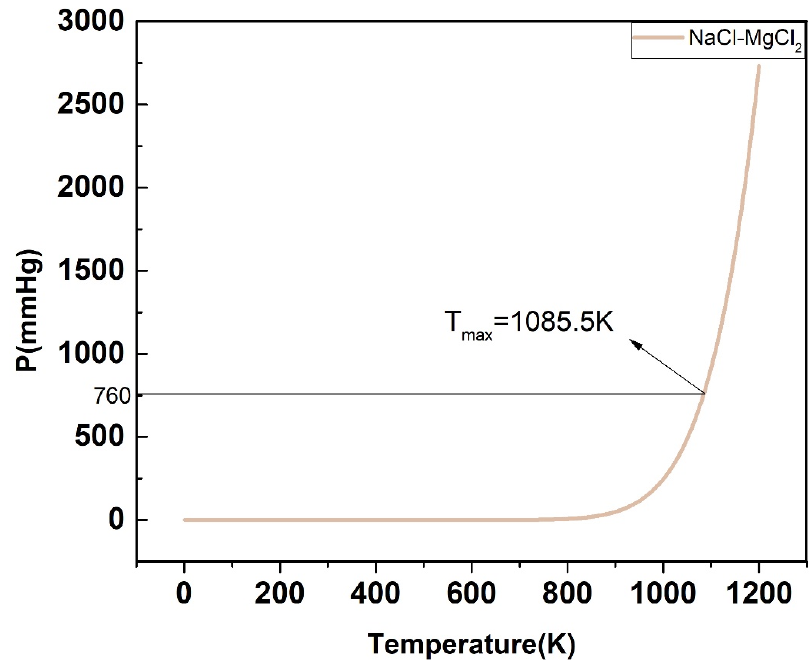
Figure 20. Calculated P-T phase diagram of the NaCl-MgCl 2 binary system.